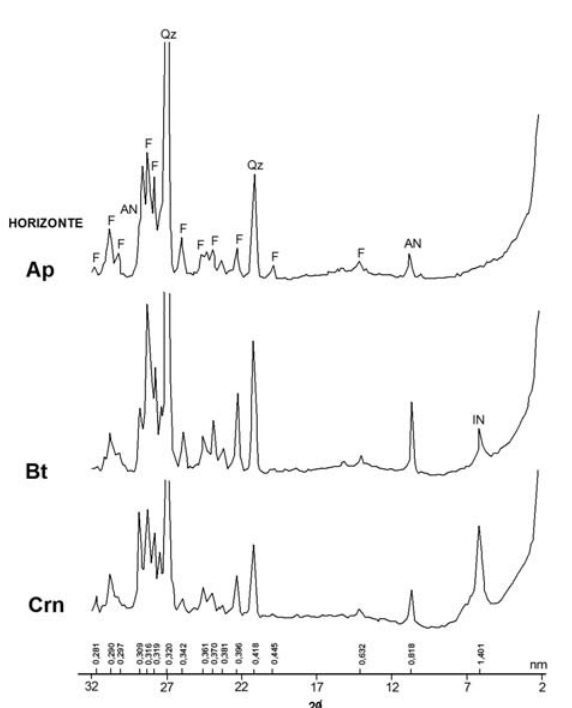
Figura 3. Difratograma de raios X da fração silte do perfil 3, Planossolo Háplico Sálico solódico. F: feldspato; AN: anfibólio; Qz: Quartzo; IN: